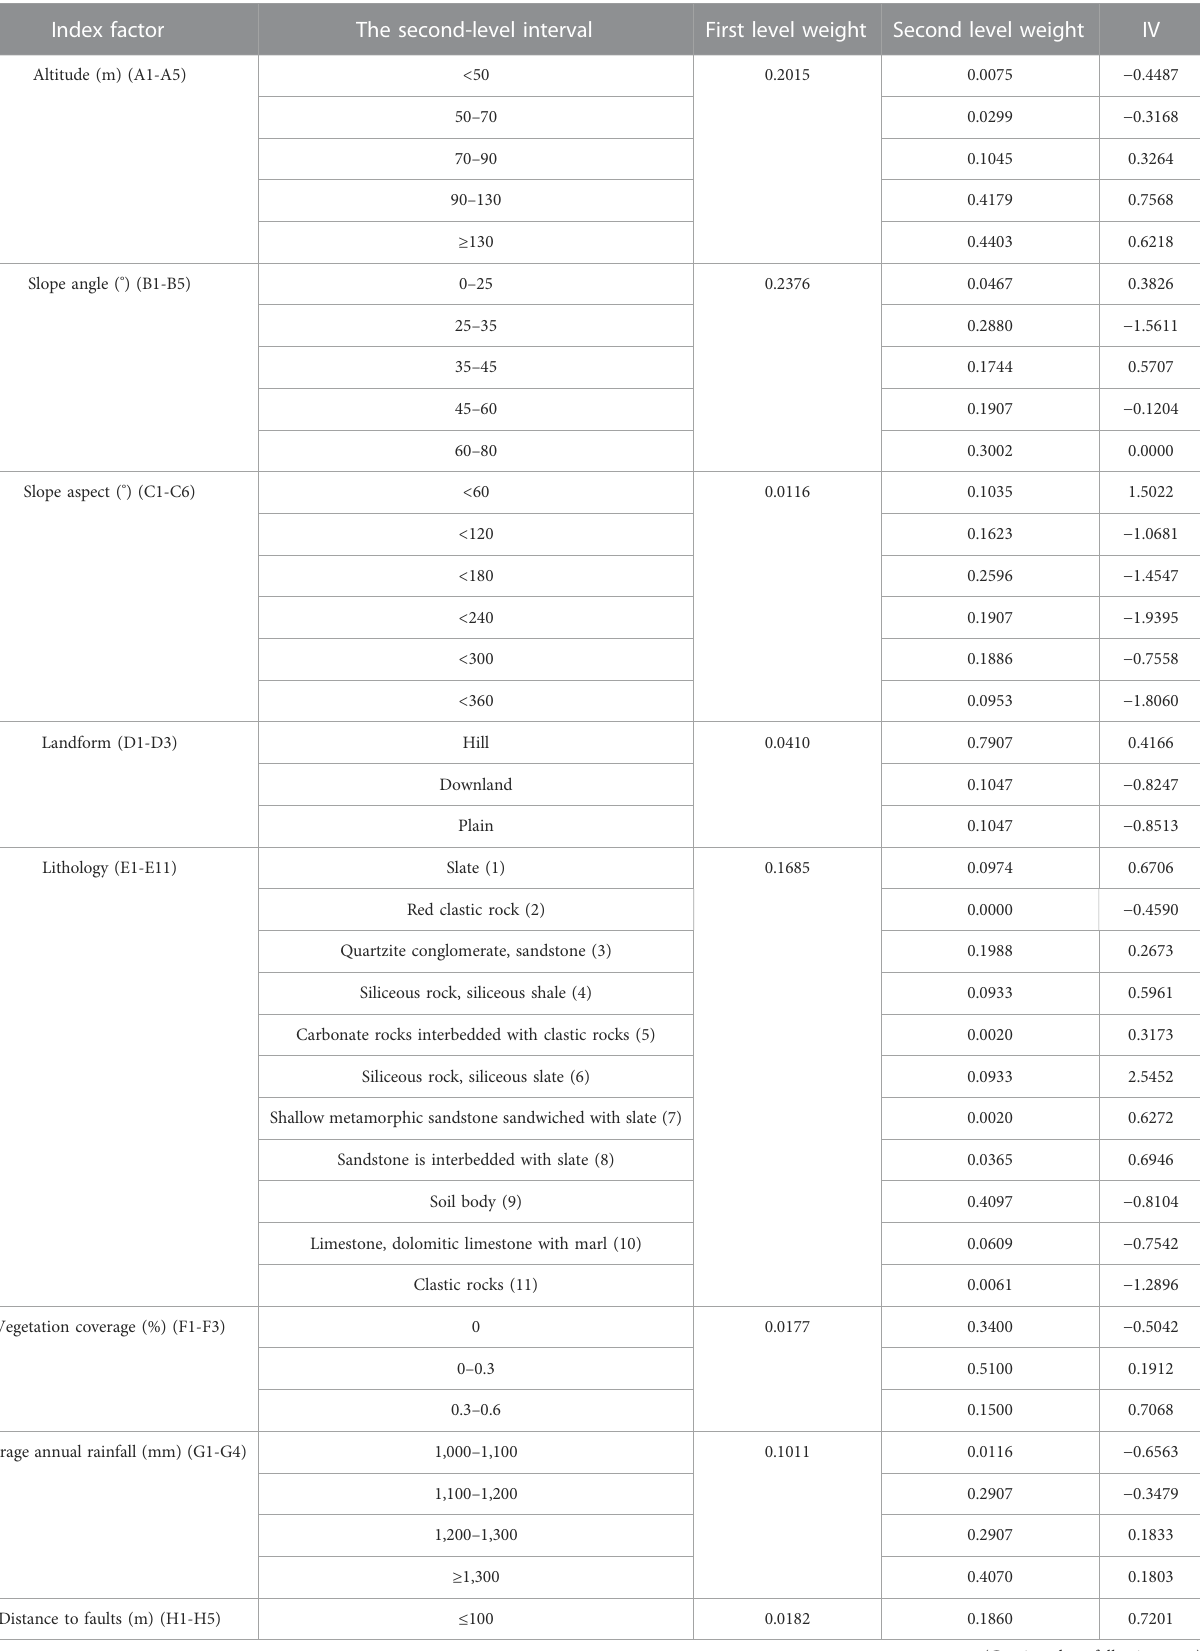
TABLE 3 Calculation results of grading weight and information value (IV) of each evaluation